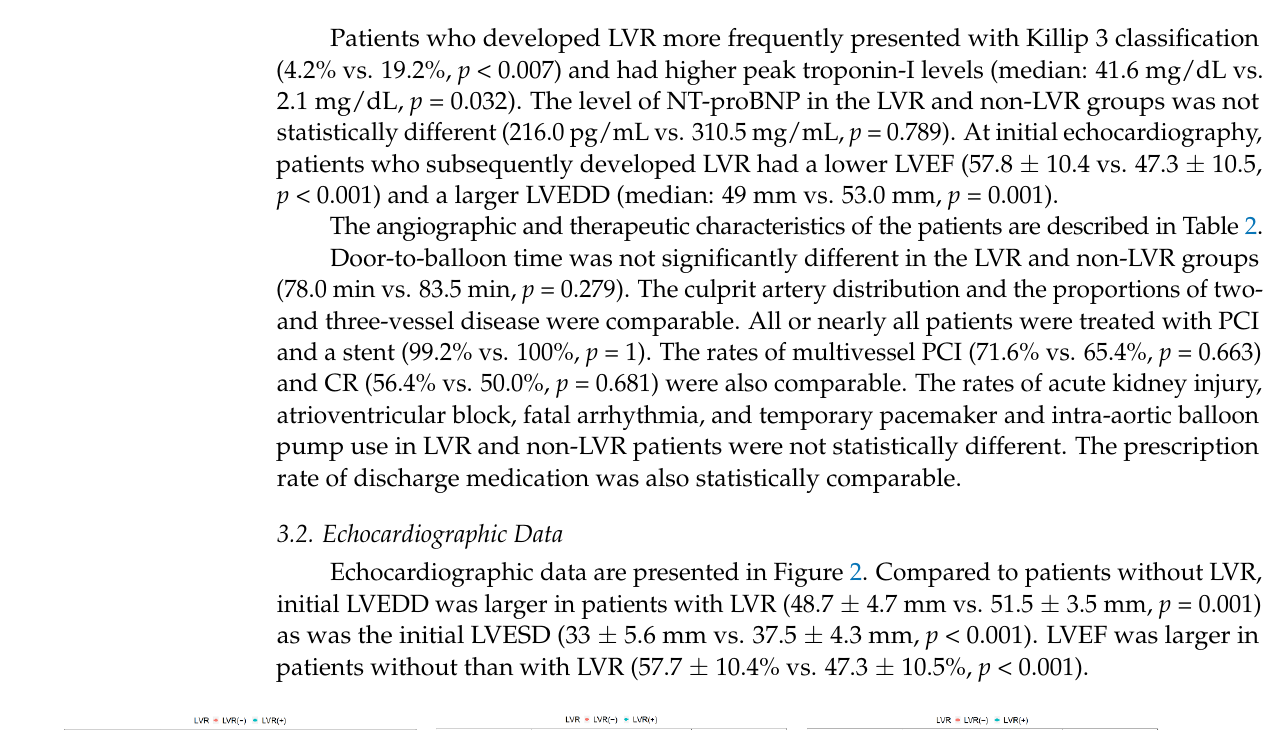
Table 3. Logistic regression: Factors related to LV remodeling.